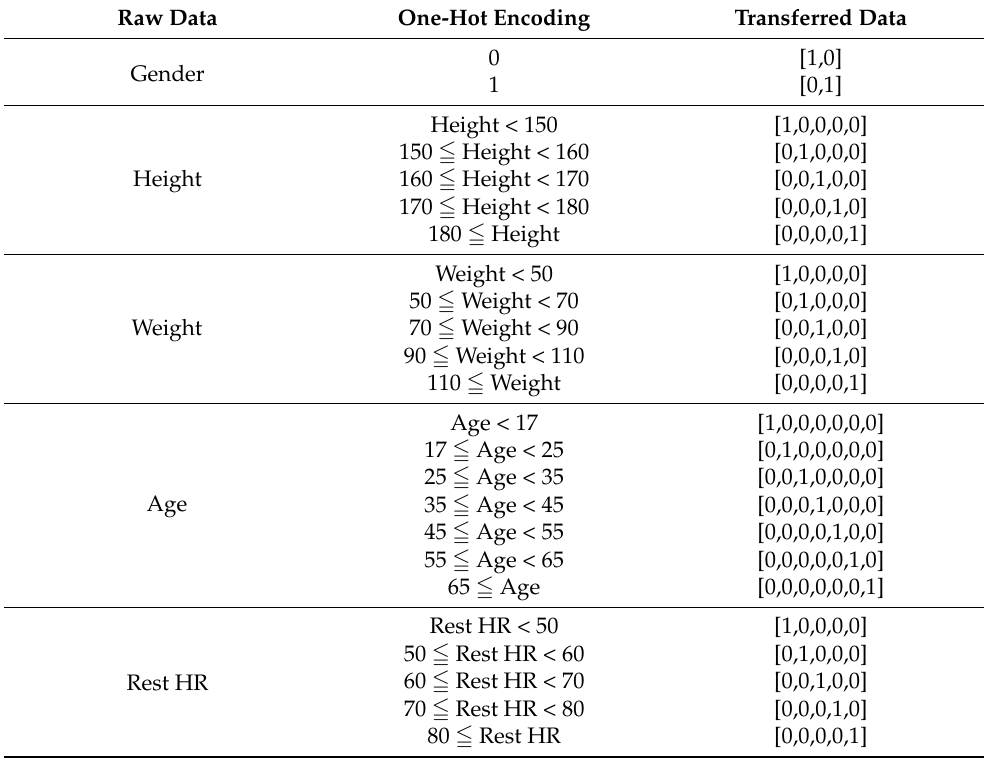
Table 1. Different range to transfer raw value of input data into one-hot